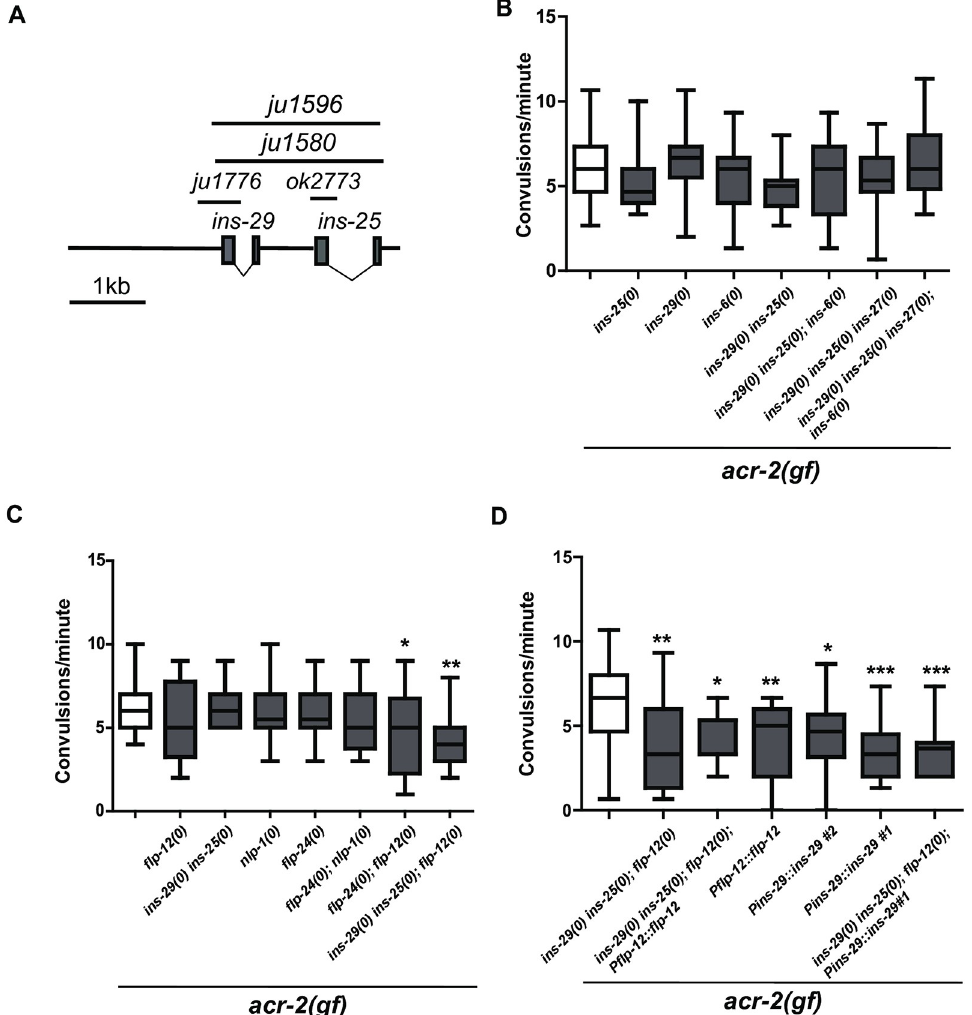
Fig 5. ILPs and flp-12 coordinately promote motor circuit activity. A. Shown is the ins-29 and ins-25 gene structure with illustrations of the deletion mutants used in this study. ok2773 is a 354bp deletion in ins-25 . ju1776 is a 568bp deletion in ins-29 . ju1580 is a 2.2kb deletion of both ins-25 and ins-29 , and a similar deletion, ju1596 , is made in ins-27 (ok2474) genetic background, which is ~6kb 3’ to ins-25 . B. Convulsion rate of acr-2(gf) combined with different combinations of deletions in genes for insulin-like peptides up-regulated in acr-2(gf) neurons is shown as convulsions/ minute. None of these combinations had a statistically significant effect of convulsion rate. Box-and-whisker plots are shown with the middle bar representing the median (One-way ANOVA followed by Dunnett’s test. N � 18). C. Convulsion rates for indicated genotypes are shown. Deletion of flp-12 in combination with either flp-24(0) or deletion of both ins-29 and ins-25 causes a statistically significant reduction in convulsion rate. Box-and-whisker plots are shown with the middle bar representing the median ( � P < 0.05, �� P < 0.01. One-way ANOVA followed by Dunnett’s test. N � 19). D. Over-expression of either flp-12 or ins-29 suppresses convulsion. Over-expression arrays of flp-12(juEx7964) or ins-29 (juEx7966 , juEx7967) were crossed into indicated mutant backgrounds and scored for convulsion. Box-and-whisker plots are shown with the middle bar representing the median ( � P < 0.05, �� P < 0.01, ��� P < 0.001. One-way ANOVA followed by Dunnett’s test. N �